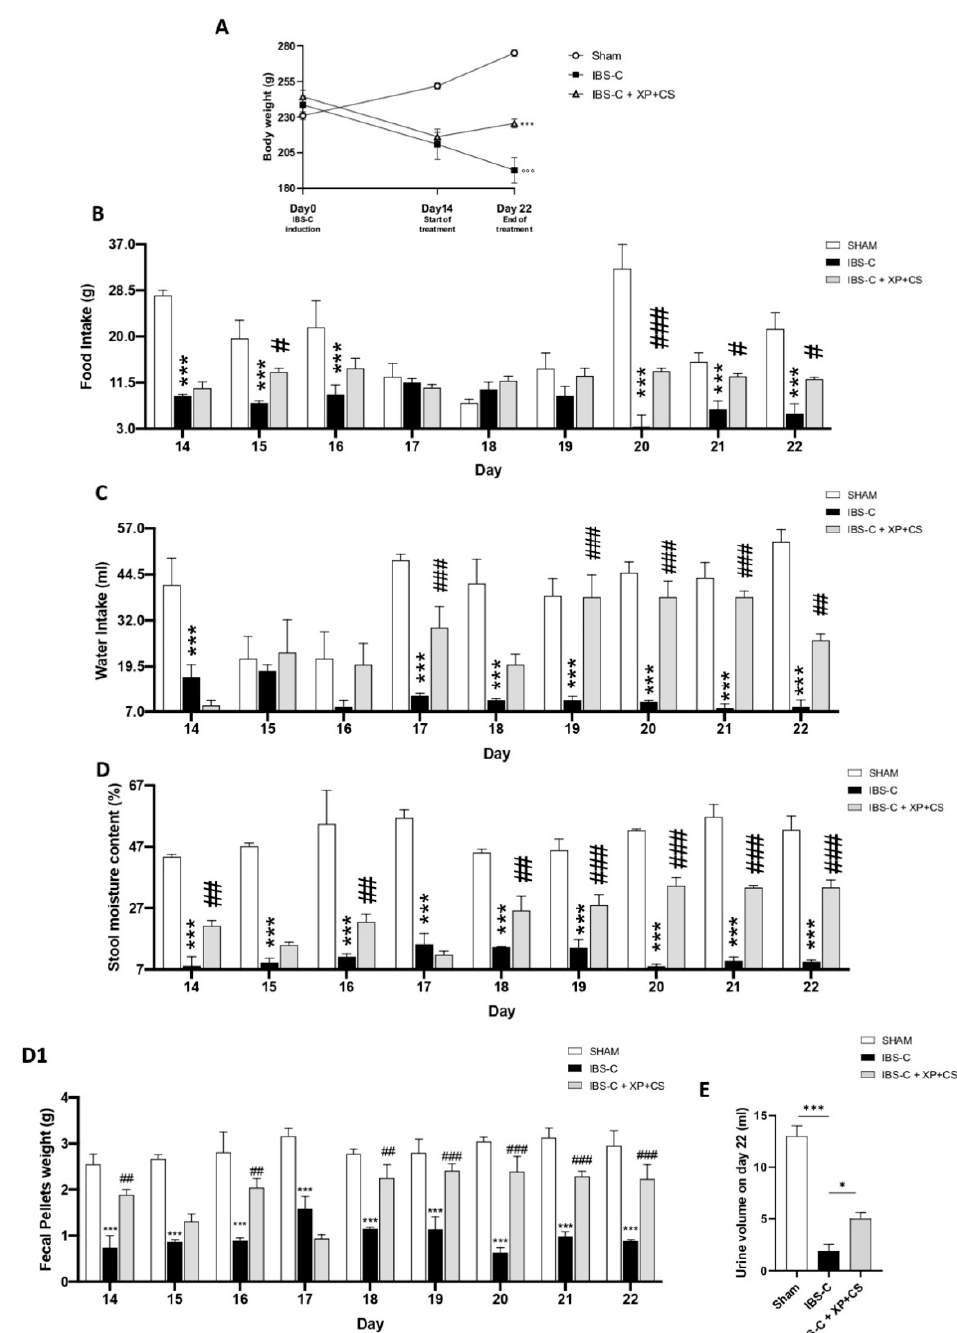
Figure 1. XP and CS effects on body weight, food and water intake, stool content and urine volume. ( A ) Analysis of body weight (days 0 to 22). ◦◦◦ p < 0.001 vs. Sham; *** p < 0.001 vs. IBS-C. ( B , C ) Food and water intake measured from day 0 to 22. *** p < 0.001 vs. Sham; # p < 0.05 vs. IBS-C; ### p < 0.01 vs. IBS-C; ### p < 0.001 vs. IBS-C. ( D ) Stool moisture content percentage measured from day 0 to 22 *** p < 0.001 vs. Sham; ## p < 0.01 vs. IBS-C; ### p < 0.001 vs. IBS-C. ( D1 ) Fecal pellets weight. *** p < 0.05 vs. Sham; ## p < 0.01 vs. IBS-C; ### p < 0.001 vs. IBS-C. ( E ) Urine volume measure on day 22. *** p < 0.001 vs. Sham; * p < 0.05 vs. IBS-C.